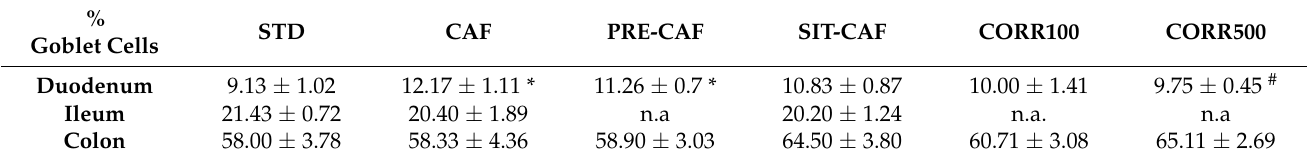
Table 7. Percentage of Goblet cells in duodenum, ileum and colon H&E slides in different groups. Values represent mean ± SEM; n = 3–8